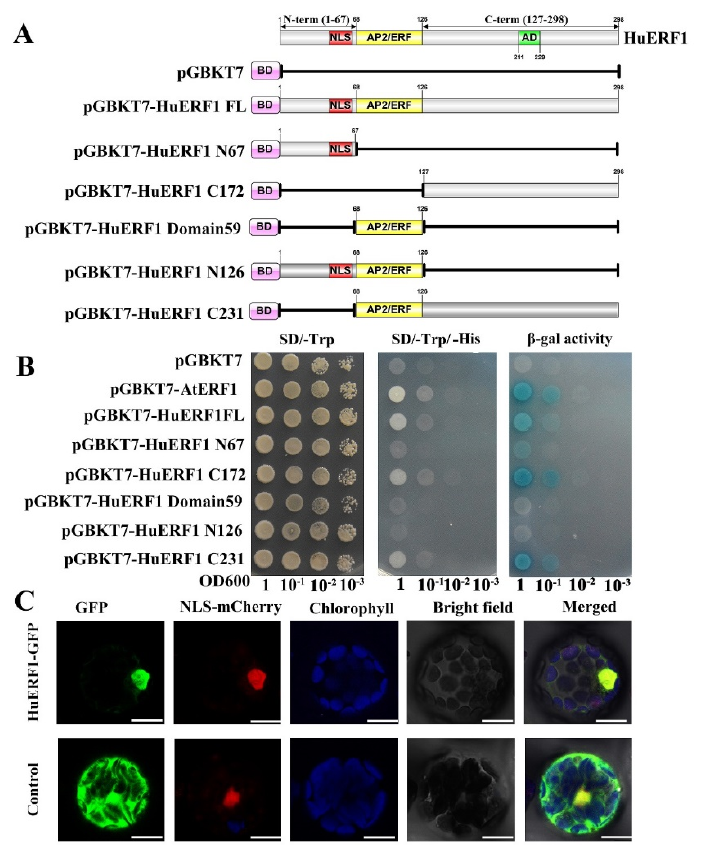
Figure 5. Transcriptional activation activity and nuclear localization of HuERF1. ( A ) Transactivation activity analysis of the GAL4 DNA binding domain-HuERF1 fusion assay in yeast. The GAL4 DNA binding domain was fused with the full-length and truncated forms of HuERF1 and transformed into the yeast strain AH109. ( B ) Analysis of activity of the yeast strains on plates. The yeast AH109 containing plasmids that encode GAL4-HuERF1 was cultured on SD / -Trp (left), SD / -Trp / -His (middle), and α -galactosidase activity (right). The yeast culture was serially diluted to OD 600 values of 0.1, 0.01, 0.001, and then the 5- µ L yeast liquid was spotted on SD plates and incubated for 4 days at 30 ◦ C. ( C ) Nuclear localization of HuERF1. Subcellular localization of HuERF1 in Arabidopsis protoplasts observed under a laser scanning confocal microscope. The blue color indicates the autofluorescence emitted by chloroplasts; the red color indicates the nucleus using NLS-mCherry as the nuclear marker. Bars = 10 µm.